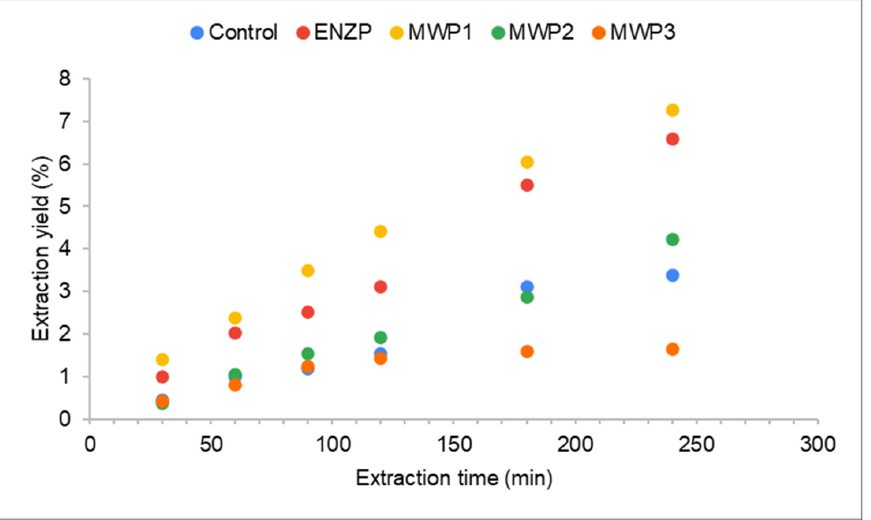
Figure 2. Supercritical carbon dioxide extraction kinetics of oregano (pressure 200 bar, temperature 40 °C, extraction time 4 h).